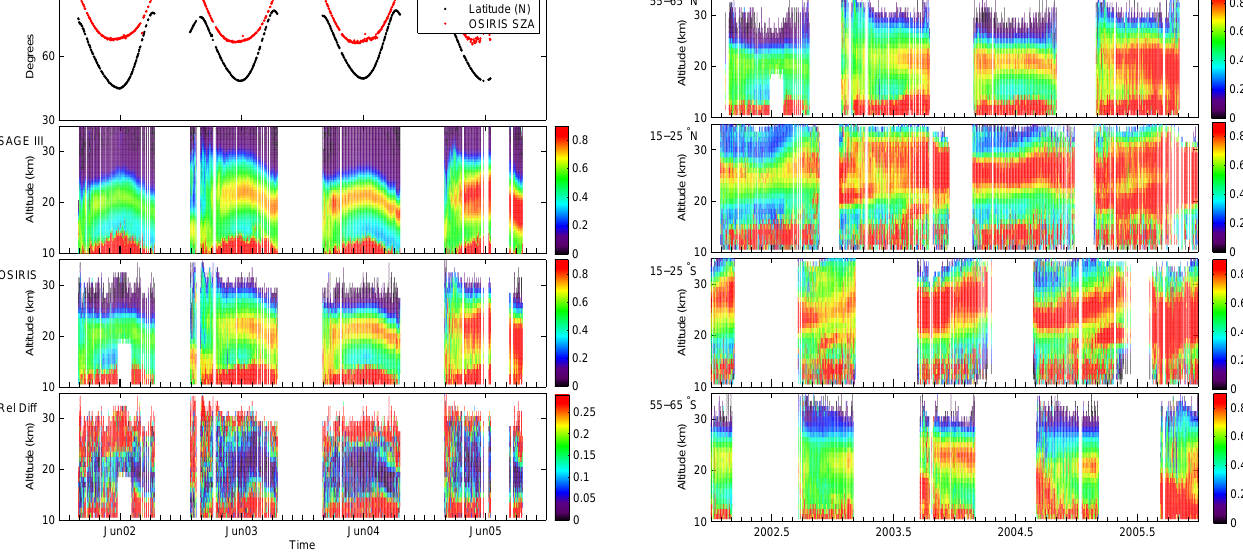
Fig. 6. A time series of the SAGE III, OSIRIS, and absolute rela- tive difference aerosol extinction ratio profiles as a daily zonal av- erage. Data is only shown when both instruments are making mea- surements; periods when sunlit measurements are not possible for OSIRIS due to solar zenith angle greater than 90 ◦ or when OSIRIS was turned off for engineering tests are indicated in white. OSIRIS profiles include all measurements within ± 5 ◦ of the SAGE III av- erage daily latitude. From top to bottom, the plots show the latitude and solar zenith angle of the measurements, the SAGE III zonal av- erage, the OSIRIS zonal average and the absolute relative difference between the two zonal average measurements.